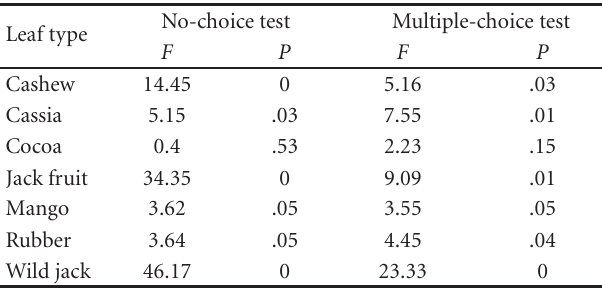
Table 3: One-way ANOVA for the quantity of tender and senescent leaves consumed by L. tristis in no-choice and multiple-choice experiment